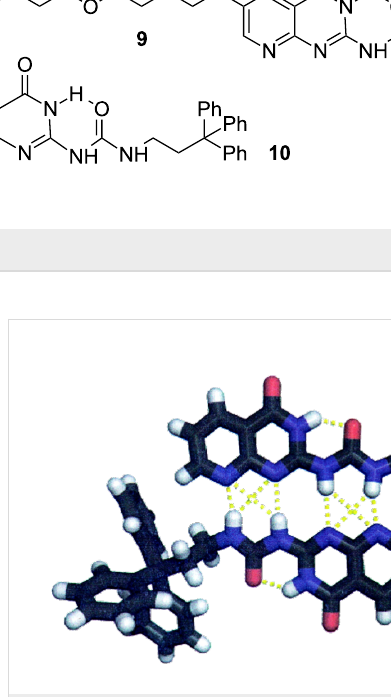
Figure 1: X-ray structure of 10 showing a quadruple hydrogen-bonded dimeric motif [17].